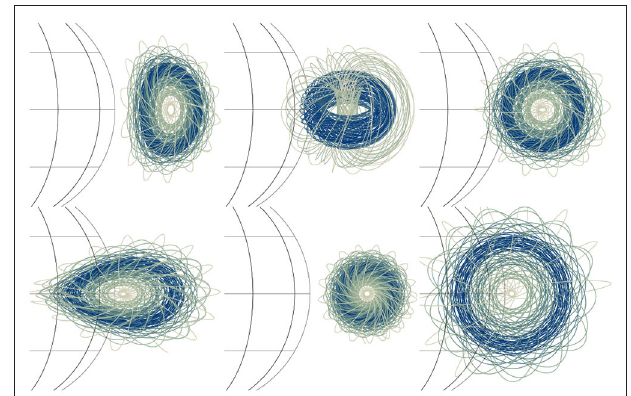
FIGURE 1 | Examples of various initial G&L configurations. Blue and green lines are magnetic field lines sampling the magnetic structure of the G&L spheromak, shown here with different combinations of parameters for angular size, topology, orientation. The solar surface is shown in thin black lines for reference.